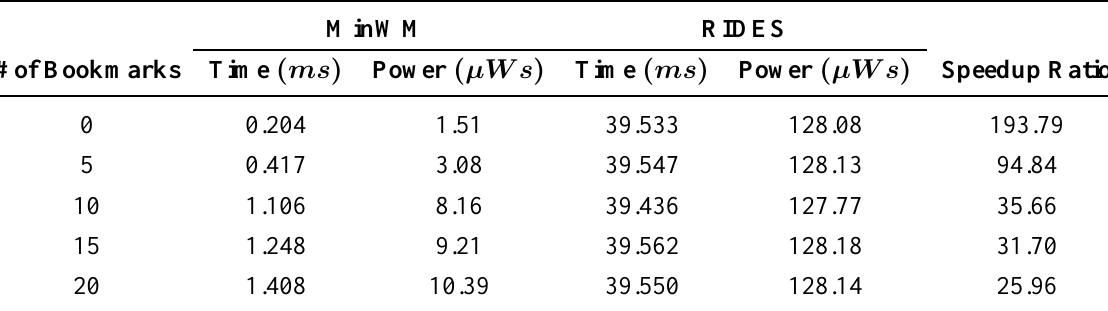
Table 1. Required resources to examine a single